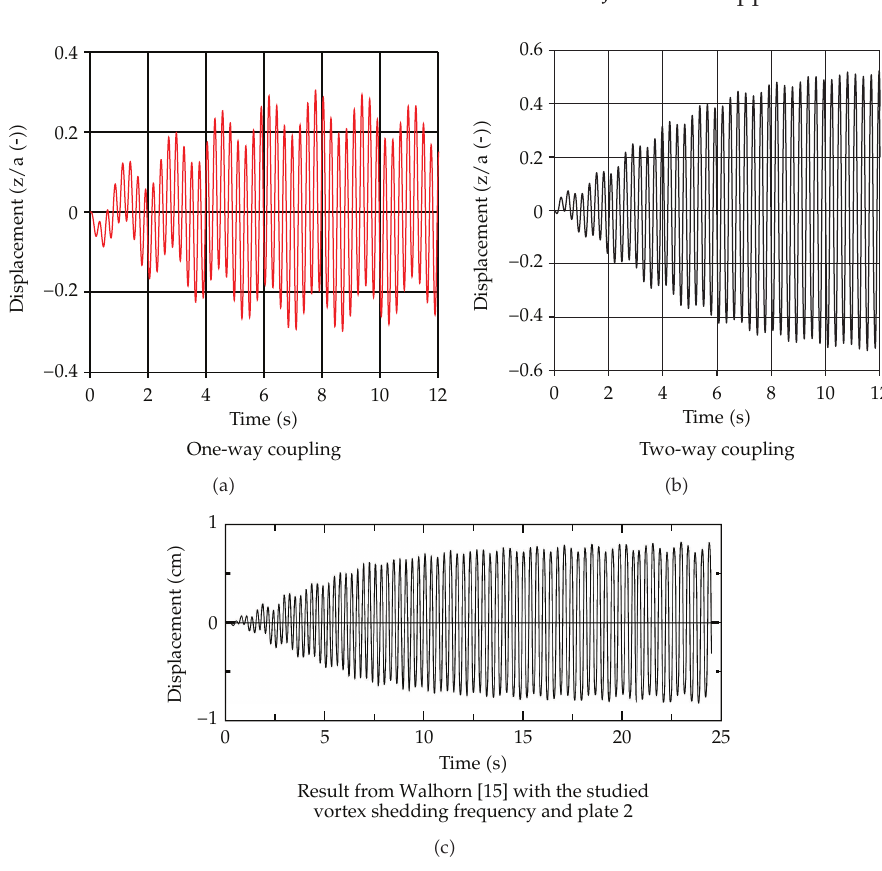
Figure 11: Displacement over time, v (cid:8) 0 . 34m/s, plate 2.